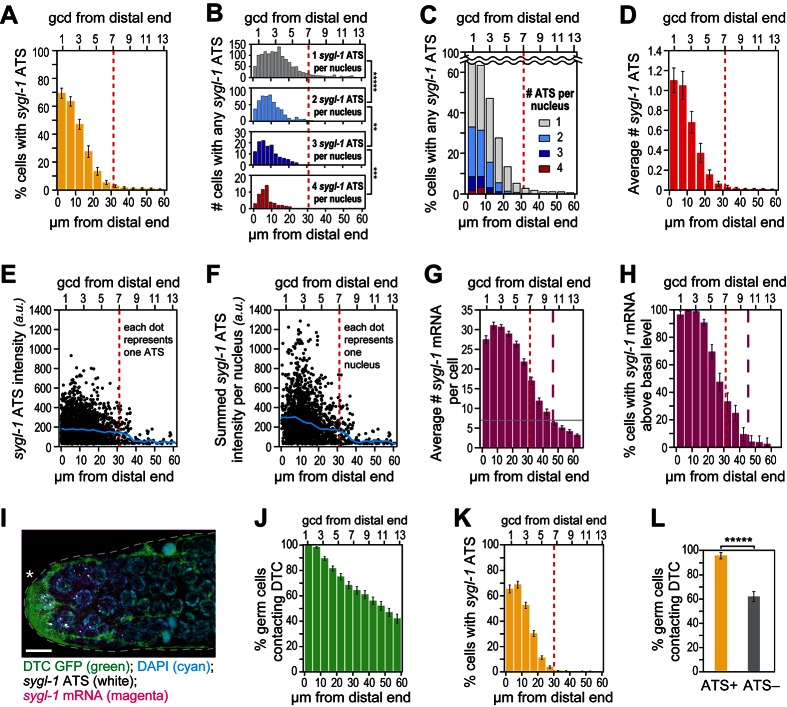
The sygl-1 transcriptional response is spatially graded.(A–H and K,L) sygl-1 smFISH signals as a function of position along the distal-proximal axis of adult gonads. Positions were measured at 5 μm (A,C–K) or 2 µm (B) intervals from the distal end (x-axis below each graph), and translated to the conventional measure of germ cell diameters (gcd) from the distal end (x-axis above each graph). Error bars: standard error of the mean (SEM). n = 78 gonads. Red dashed line marks the site where the mean percentage of ATS-positive germ cells falls lower than 5%; purple dashed line marks the site where the mean percentage of mRNA-positive germ cells falls lower than 5%. (A) Gradient in percentage of germ cell nuclei with any number of sygl-1 ATS as a function of distance from the distal end in the wild-type adult gonad. By contrast, that percentage is essentially uniform in glp-1(gf) gonads (Figure 3—figure supplement 1A). (B) Numbers of cells with one, two, three or four sygl-1 ATS per nucleus as a function of distance from distal end. Total n = 2058 nuclei. **p<0.01, ***p<0.001, *****p<0.00001 by t-test. (C) Percentages of total ATS-positive nuclei that have one, two, three or four sygl-1 ATS per nucleus as a function of distance from distal end. Total n = 2058 nuclei. (D) Average number of sygl-1 ATS as a function of distance from the distal end. (E) Signal intensities of individual sygl-1 ATS do not change substantially in region of graded ATS (1–7 gcd, border marked with red line). Each dot represents a single sygl-1 ATS. The blue curve indicates mean ATS intensity. n = 2978 ATS. Signal intensities of individual sygl-1 ATS are comparable in glp-1(gf) gonads (Figure 3—figure supplement 1B). (F) Summed sygl-1 ATS intensities per nucleus were used as a measure for total sygl-1 nascent transcripts per nucleus and then plotted as a function of distance from the distal end, with each dot representing a single nucleus. The blue curve shows the mean for summed ATS intensities at each position relative to the distal end. n = 2058 nuclei. (G) The number of sygl-1 cytoplasmic mRNA per cell as a function of distance from the distal end. Boundaries of cells were estimated using 3-D Voronoi diagram (Figure 3—figure supplement 2A; see Materials and methods for details). The grey line marks the average basal sygl-1 mRNA level, which was calculated by averaging sygl-1 mRNA density over a region where mRNAs are both least abundant and no longer graded (the 40–60 μm interval in each gonadal image). A cell with abundant sygl-1 mRNA can reside next to a cell with few mRNA (Figure 3—figure supplement 2B–E). (H) Percentage of germ cells with sygl-1 cytoplasmic mRNAs above basal level as a function of distance from the distal end. (I) sygl-1 smFISH in adult distal gonad with DTC and its processes visualized with myristoylated GFP (green) and nuclei seen with DAPI (blue). sygl-1 exon probes mark cytoplasmic mRNAs (magenta) and intron probes (yellow) highlight ATS. Overlap is in white. Conventions and scale as in Figure 1E. Z-projection is shown. (J-L) Quantitative analyses of sygl-1 response in animals where DTC was marked with myristoylated GFP, n = 60 gonads at 24 hr post mid-L4 stage. Error bar: SEM. (J) Percentage of germ cells in contact with DTC or its processes as a function of distance from the distal end. (K) Percentage of germ cells with one or more sygl-1 ATS as a function of distance from the distal end. Red dashed line marks region defined as in Figure 3A. (L) Percentage of germ cells in contact with DTC or its processes within 30 µm from the distal end. Left bar, ATS-positive cells; right bar, ATS-negative cells or without ATS. *****p<0.00001 by chi-square test for independence.